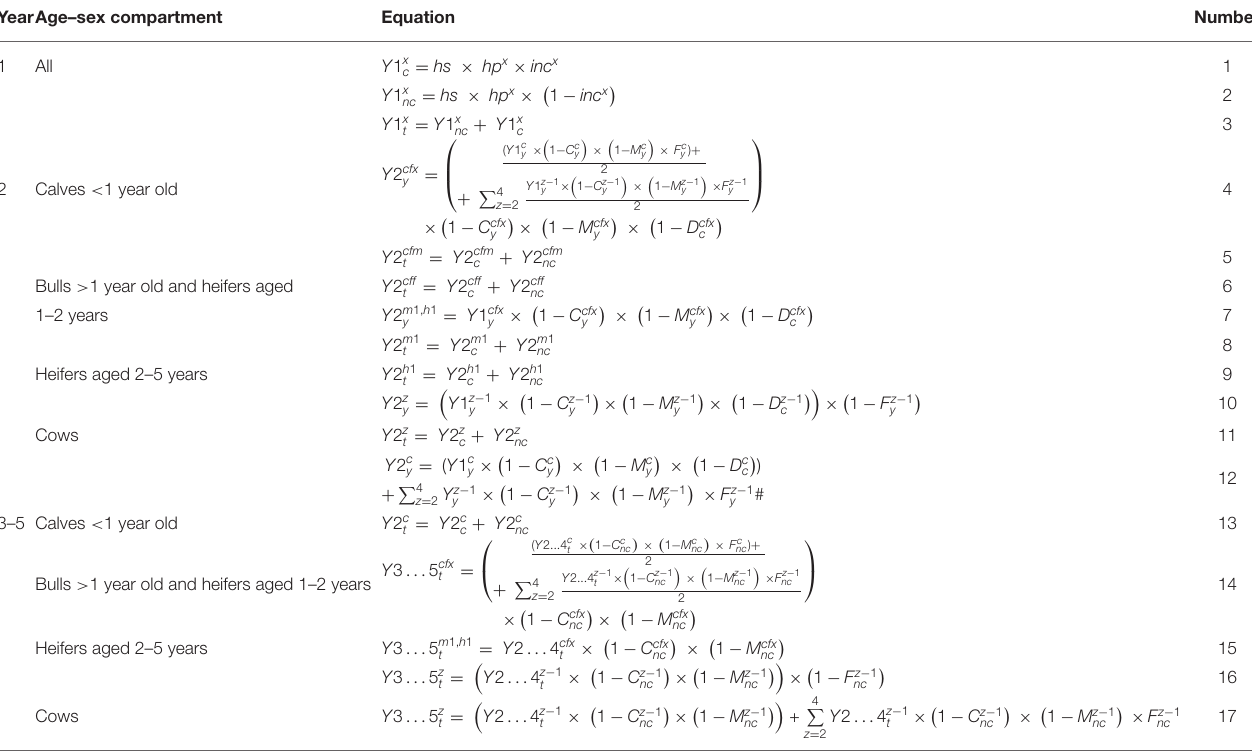
TABLE 1 | Model equations used in dairy “mixed” systems for estimating the composition of age–sex compartments for each year of the simulation. YearAge–sex